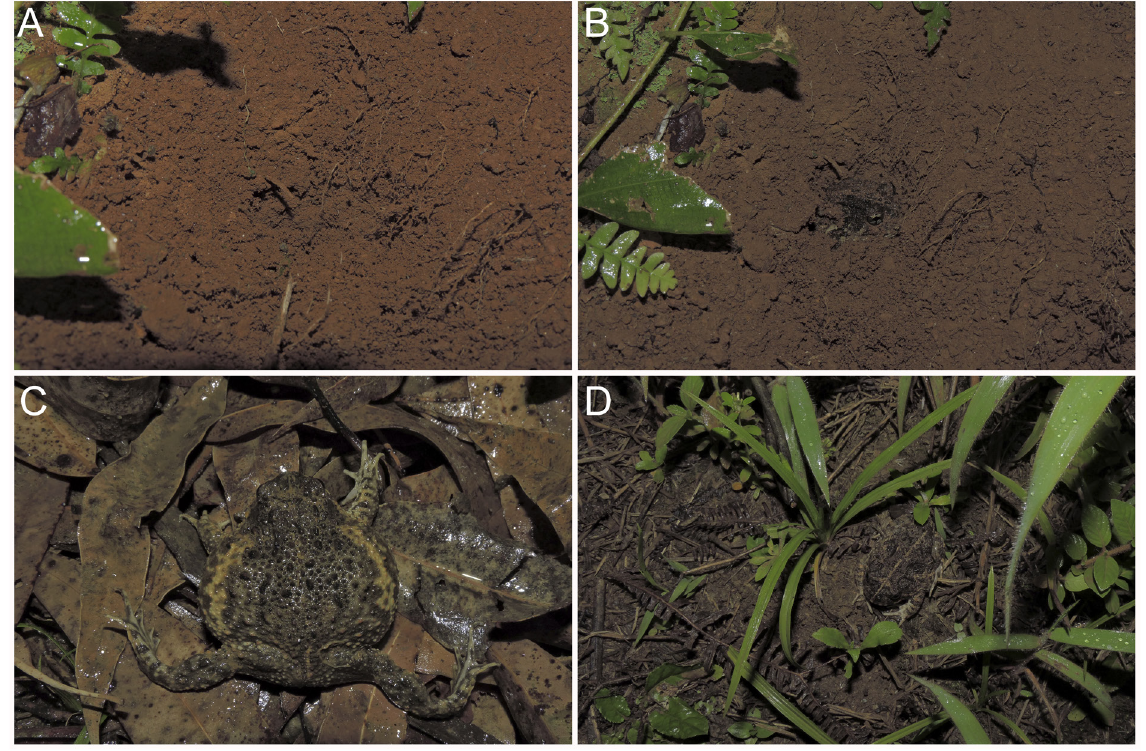
Fig. 11. Odontophrynus toledoi sp. nov. displaying defensive behaviors ( A–B ) of burrowing and ( C ) puffing up the body and stiff leg synergistically. D . The coloration of the species also provides crypsis by camouflage in the microhabitat where it